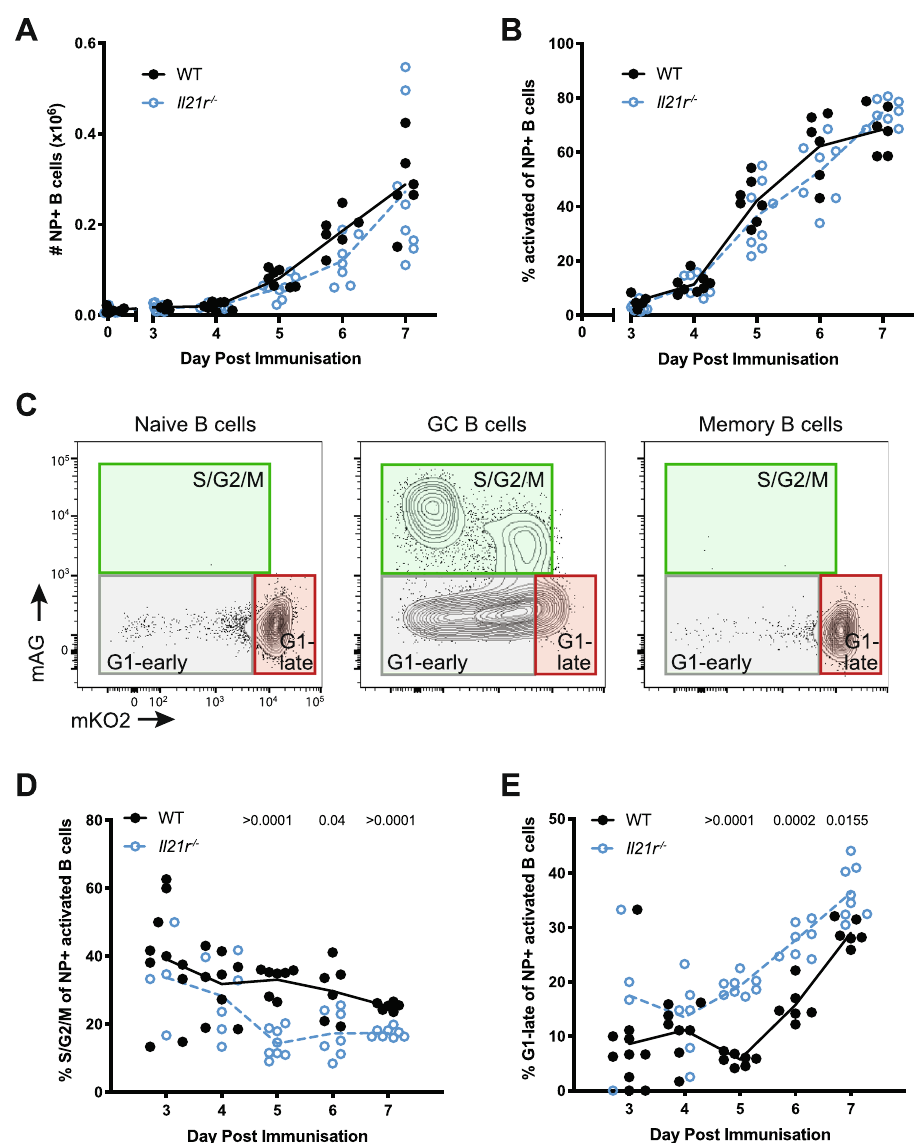
Fig. 1 IL-21 promotes proliferation in GC B cells. A WT or Il21r − / − mice were either unimmunized (day 0) or immunized i.p. with NP-KLH in alum and spleens analyzed 3, 4, 5, 6. and 7 days thereafter. The total number of NP-binding B cells (CD138 − CD19 + NP + ) among total spleen lymphocytes is shown. B The frequency of early activated cells (Fas + CD38 − ) among NP-binding B cells shown in A . C Representative mKO2 and mAG expression pro fi les on splenocytes of a mouse 7 days post immunization with NP-KLH in alum, depicting naive (CD19 + IgD + ), GC (IgD − CD19 + FAS + CD38 − NP + ), and memory (IgM − CD19 + CD38 + Fas − ) B cells. Green (mAG + ), gray (mAG − mKO2lo/ − ) and red (mKO2 hi ) boxes depict electronic gates used to identify cells in S/G2/M, G1-early, and G0 or G1-late, respectively. D , E Antigen-binding, activated B cells from NP-KLH in alum immunized WT and Il21r − / − Fucci mice analyzed for proportion of cells in S/G2/M ( D ) and G1-late ( E ). Data in A and B represent three independent experiments pooled, with a total of 6 – 12 mice per time point. Data in D and E represent n = 10, 4 (WT, Il21r − / − ; Day 3), n = 8, 6 (WT, Il21r − / − ; Day 4), n = 7, 8 (WT, Il21r − / − ; Day 5), n = 6, 7 (WT, Il21r − / − ; Day 6), and n = 6, 8 (WT, Il21r − / − ; Day 7) mice examined over three independent experiments. Only mice with ≥ 10 NP-binding GC B cells were considered for analysis. Each circle represents an individual mouse, lines connect means. Statistical signi fi cance determined by t- test and corrected for multiple comparison using the Holm – Sidak method. Exact p values are shown with those ≤ 0.05 considered signi fi cant. Source data are provided as a Source Data fi